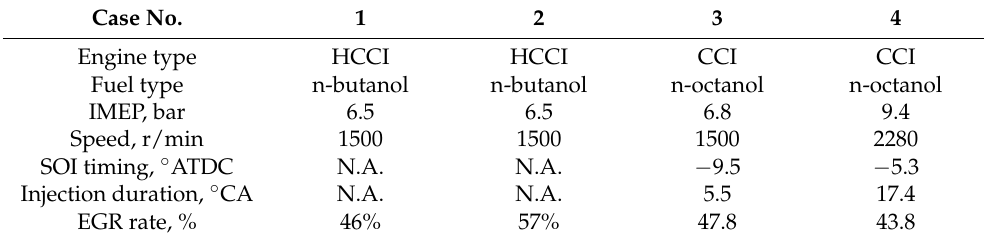
Table 2. Operating conditions of validation cases [17,22].